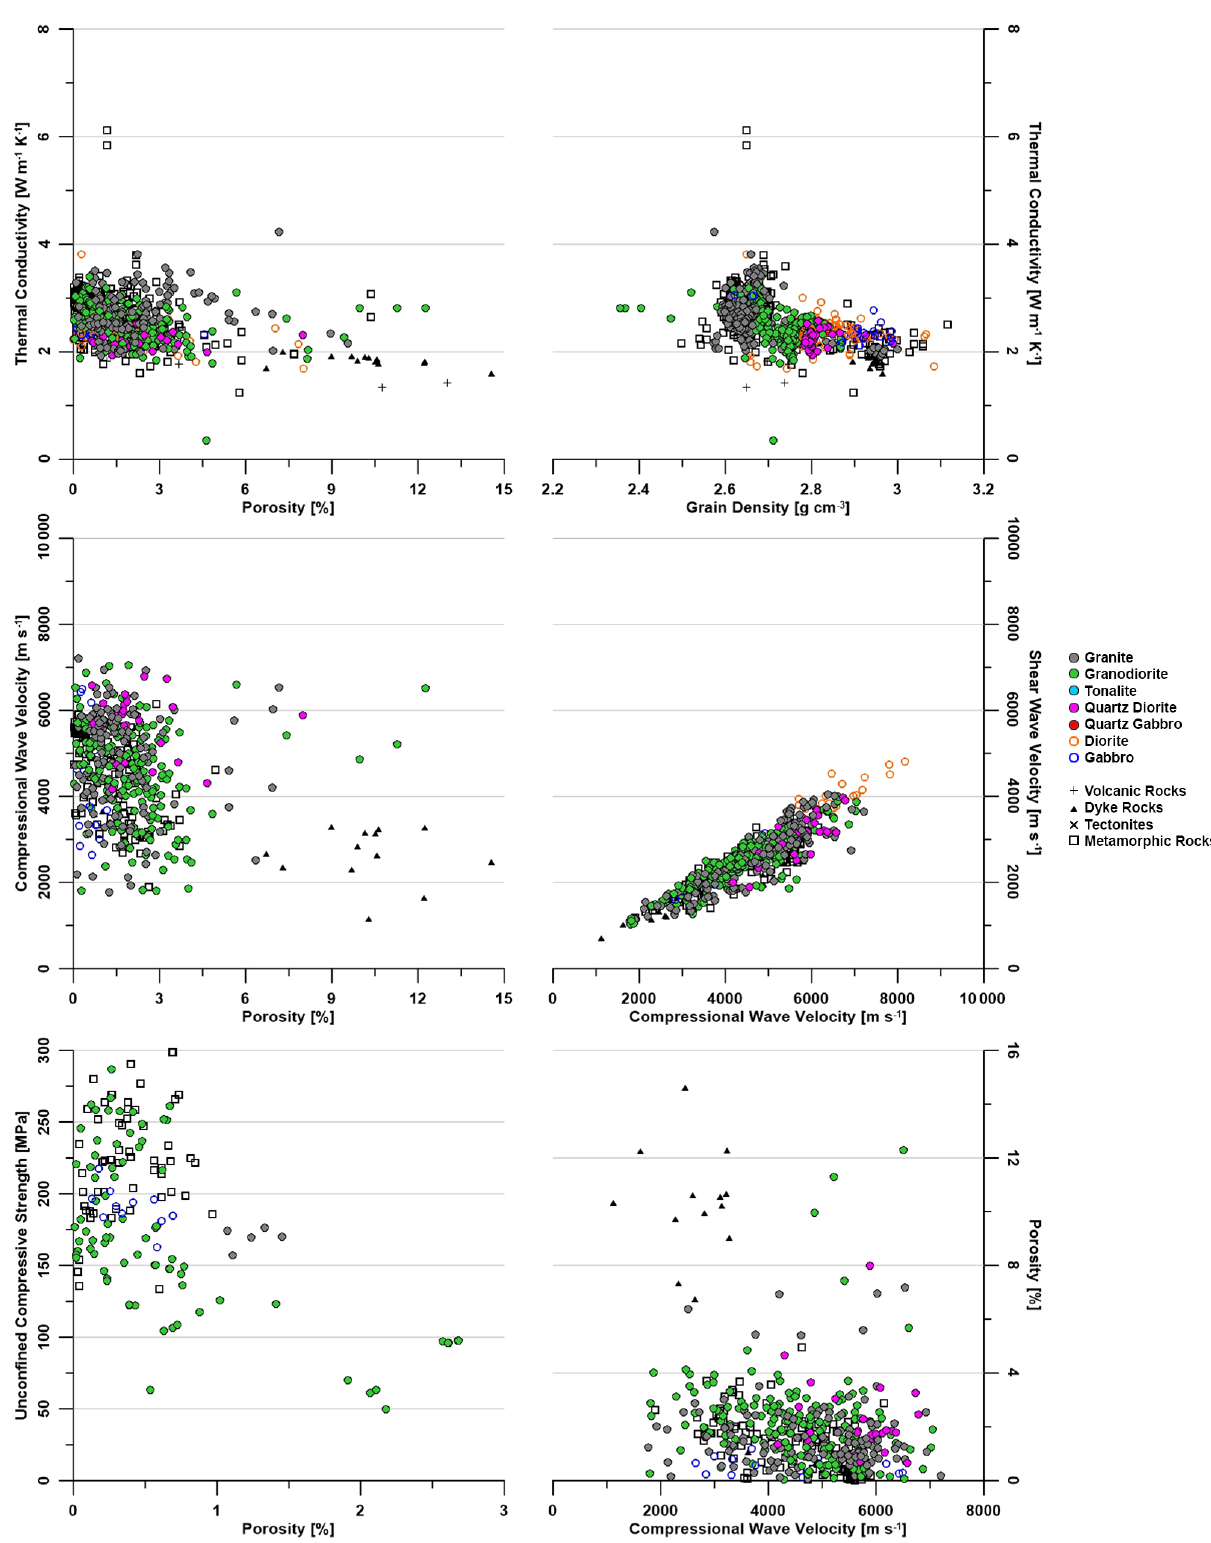
Figure 4. Scatter plots of the most common petrophysical properties of the dataset of Weinert et al. (2020b).